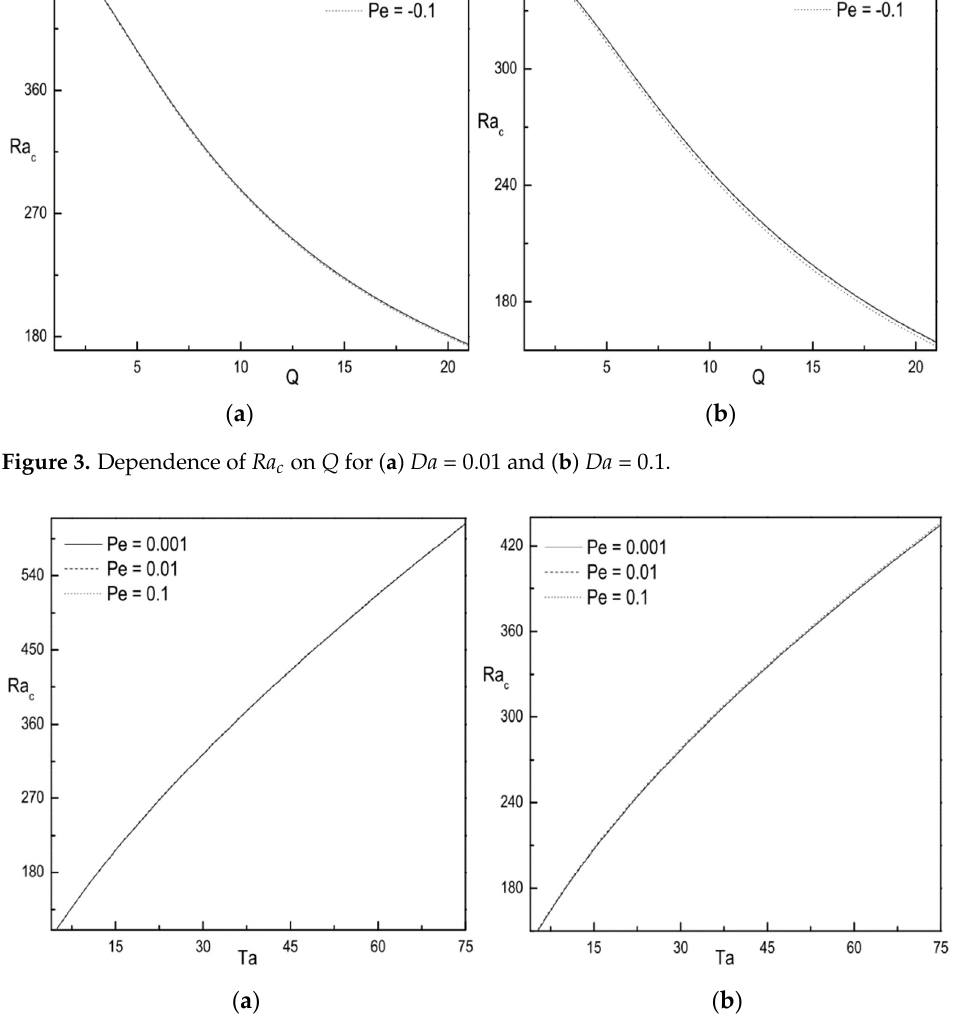
Figure 4. Dependence of Ra c on Ta for ( a ) Da = 0.01 and ( b ) Da = 0.1. Table 6 and Figure 5 show the dependence of Ra c on Ta for various Pe . Only the results for downward throughflow are shown in this part. The critical Rayleigh number rises with the increase in Ta , as shown in Figure 5, indicating that the Taylor number has a stabilizing Table 6. Critical Rayleigh number for downward throughflow fixed at Q = 2.